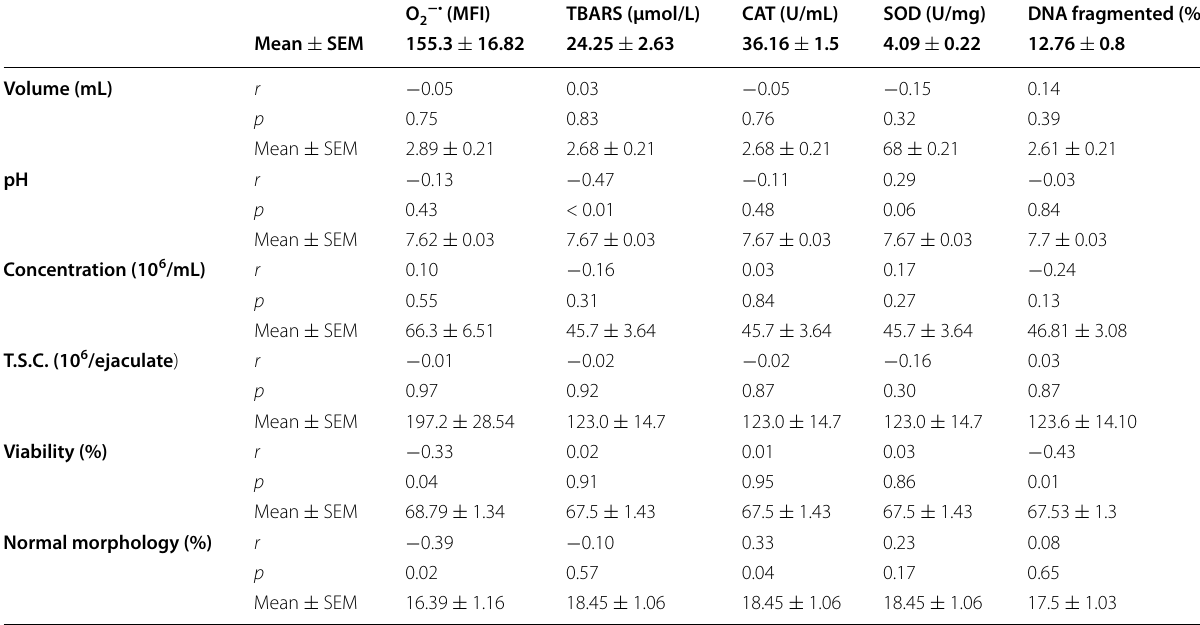
O 2 − • superoxide anion, MFI Median DHE fluorescence intensity, TBARS Thiobarbituric acid reactive substances, CAT Catalase, SOD Superoxide dismutase, T.S.C . Total sperm